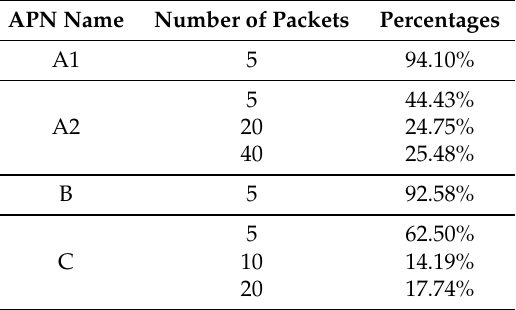
Table 3. Flows packet number distribution on different APNs.